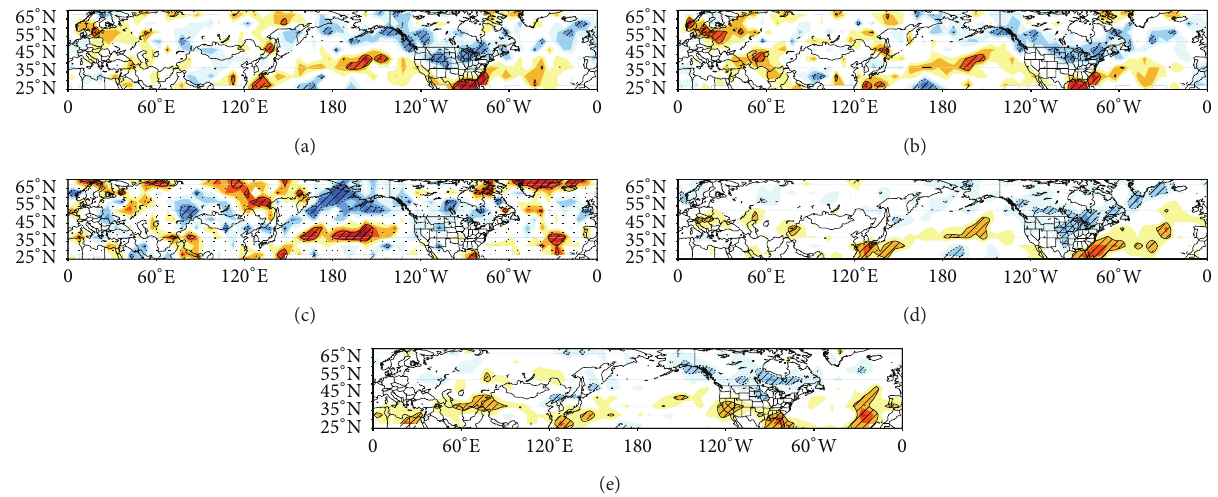
Figure 6: Partial correlation coefficient for storm frequency versus El Ni˜no for NH in JFM (excluding IOD). Correlation (shaded), 95% significance (hatched) for (a) NCEP1, (b) ERA40, (c) CFSR, (d) CMIP1, and (e)